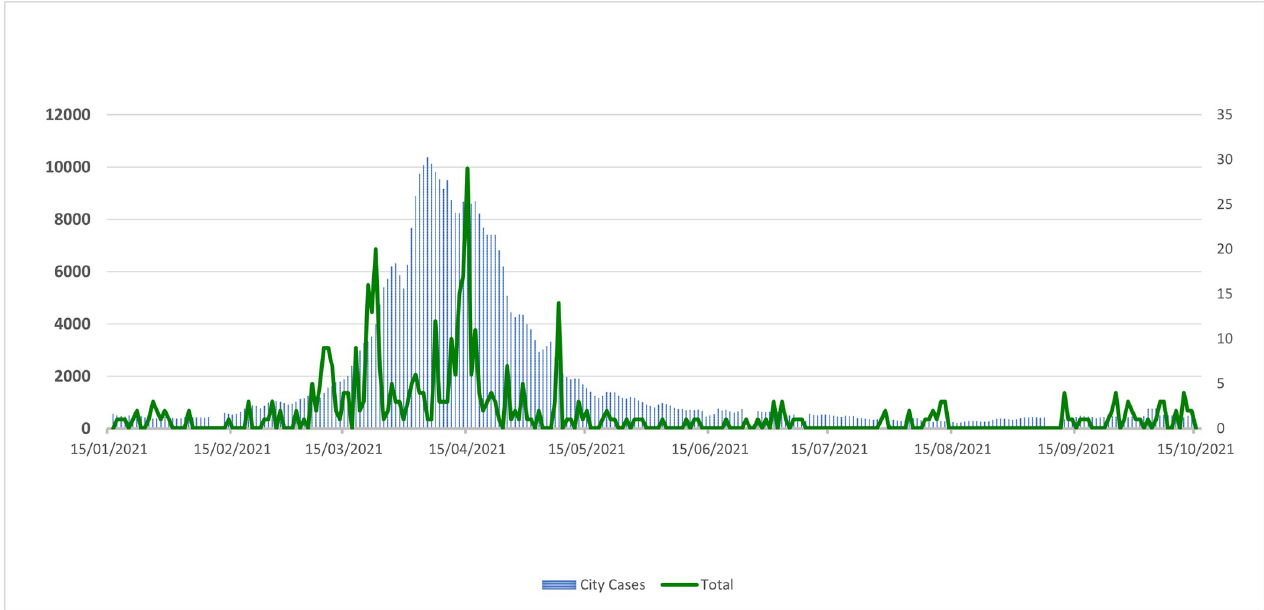
Fig 1. Figure showing the total number of cases (3-day moving average) in the city of Mumbai, and total number of new infections in our cohort, Mumbai, India.